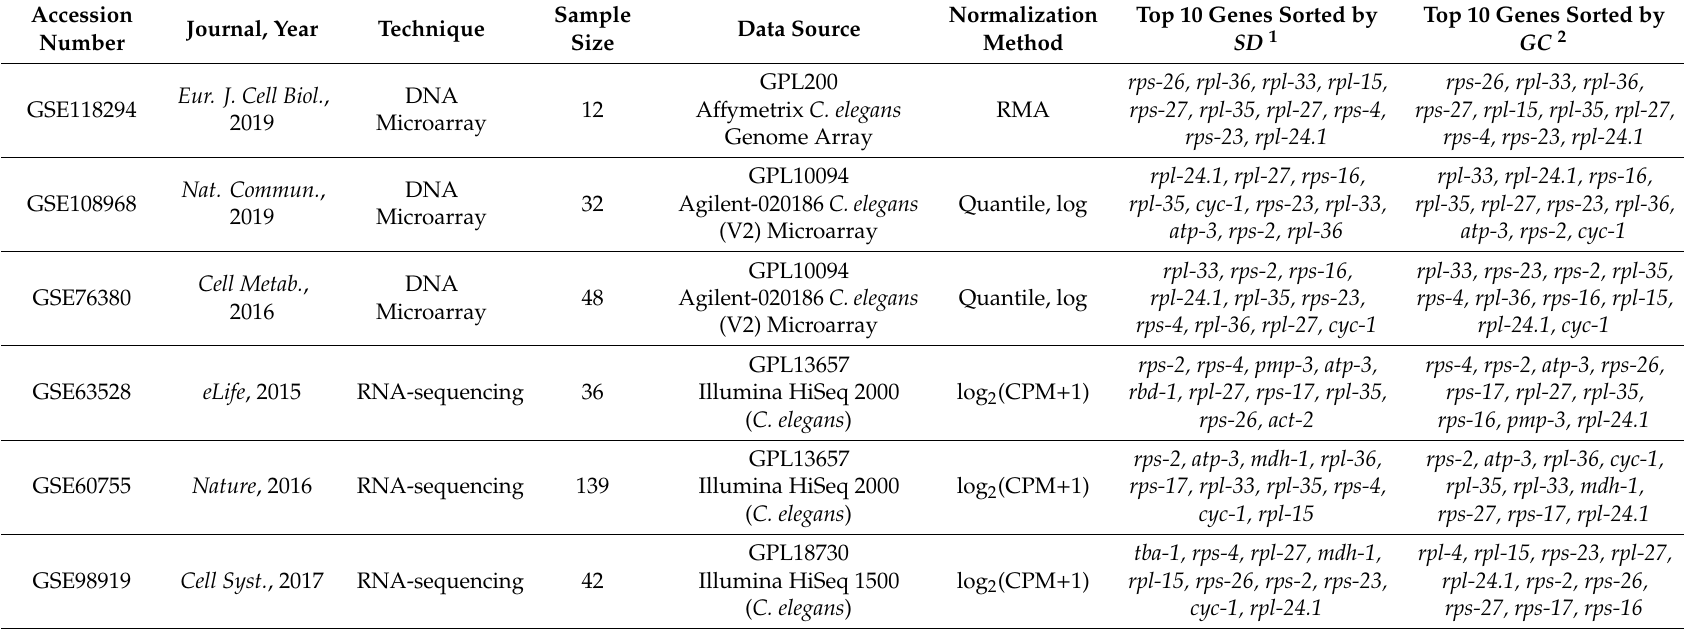
Table 2. Validation and comparison for housekeeping gene candidates in C. elegans